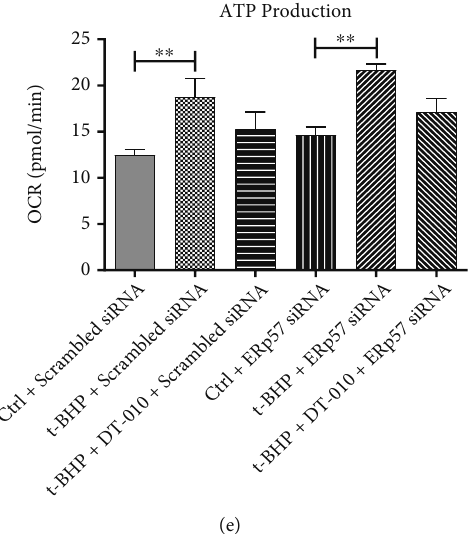
Figure 3: E ff ect of DT-010 on H9c2 cell mitochondrial respiratory function. (a) Representative oxygen consumption traces in H9c2 cells exposed sequentially to 1 μ M oligomycin, 0.5 μ M FCCP, and 1 μ M rotenone plus 1 μ M antimycin A. (b) Nonmitochondrial oxygen consumption. (c) Basal and (d) maximal respiration analysis. (e) ATP production. Data are mean ± SD of two or three independent experiments. ∗∗ P < 0 : 01 and ∗∗∗∗ P < 0 : 0001 ; # P < 0 : 05 and ## P < 0 : 01 ; $ P < 0 : 05 . Data were analyzed using one-way ANOVA and Tukey ’ s multiple comparison